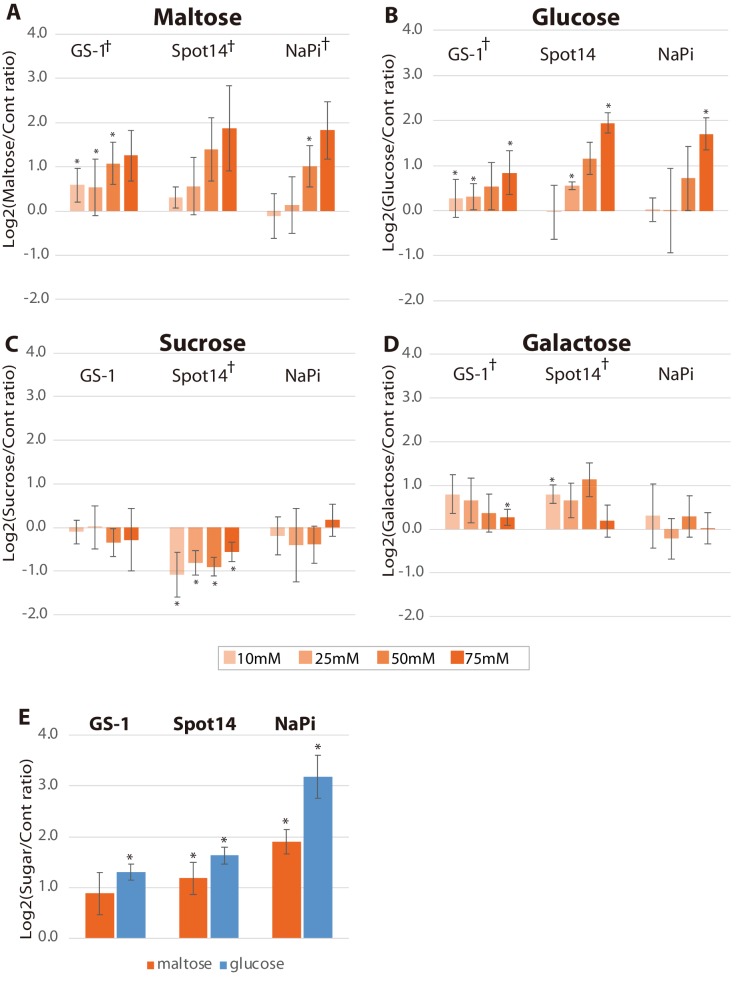
Effects of sugars on Hydra growth.Effects of growth in presence of maltose (A), glucose (B), sucrose (C) and galactose (D) on gene expression of GS-1, Spot14 and NaPi. Hv_Apo were cultured in medium containing 10, 25, 50 or 75 mM of each sugar for 48 hr, and 75 mM maltose (orange) and glucose (blue) for 6 hr (E). RNA was extracted from the polyps in the light condition. Expression difference of the genes was examined by qPCR. For each biological replicate (n = 3) 50 hydra polyps were used for total RNA extraction. The vertical axis is log scale (log2) fold change of relative expression level of sugar-treated hydras over controls. T-test (*: p-value<0.05) in each concentration and Kruskal-Wallis test (†: pvalue <0.05) in the series of 48 hr treatment were performed. Error bars indicate standard deviation.10.7554/eLife.35122.020Figure 3—figure supplement 2—source data 1.Effects in presence of maltose, glucose, sucrose and galactose on gene expression of GS-1, Spot14 and NaPi in Hv_Apo examined by qPCR.